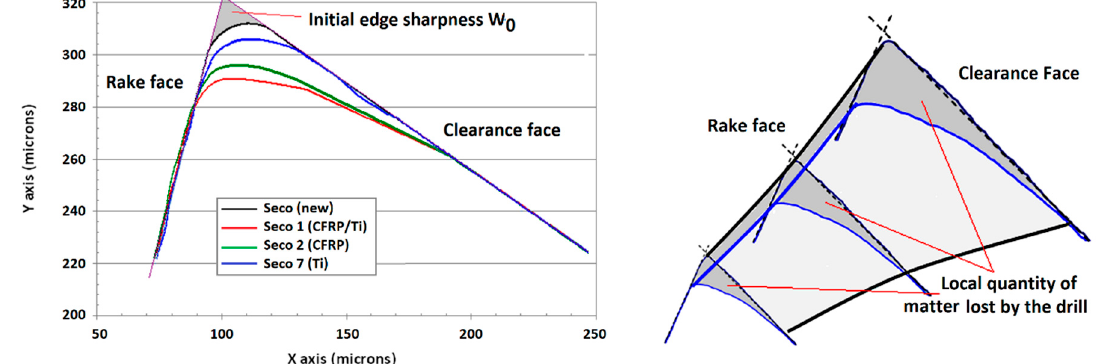
Figure 5. 2D profile of the cutting edge measured at 1200 μ m of the drill tip and reconstitution of the 3D geometry.